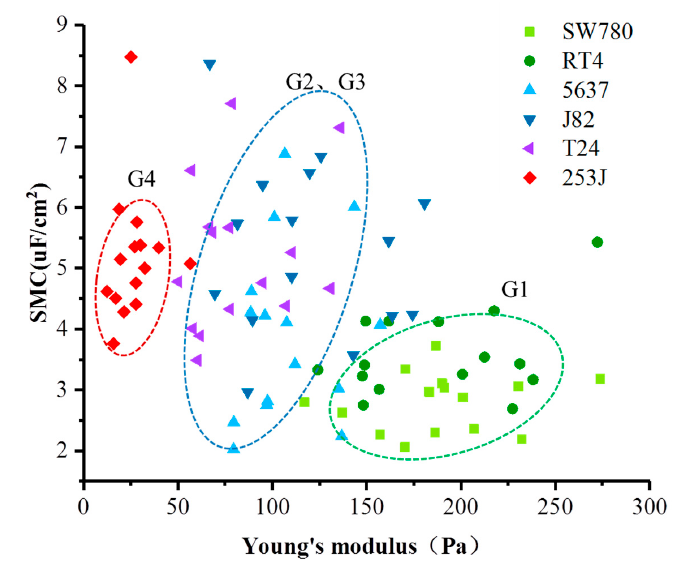
Figure 4. The scatter diagram of all data points. Points marked by different colors and shapes come from different cell lines. Almost all of the data points are divided into three groups: the blue oval area, the red oval area, and the green oval area.